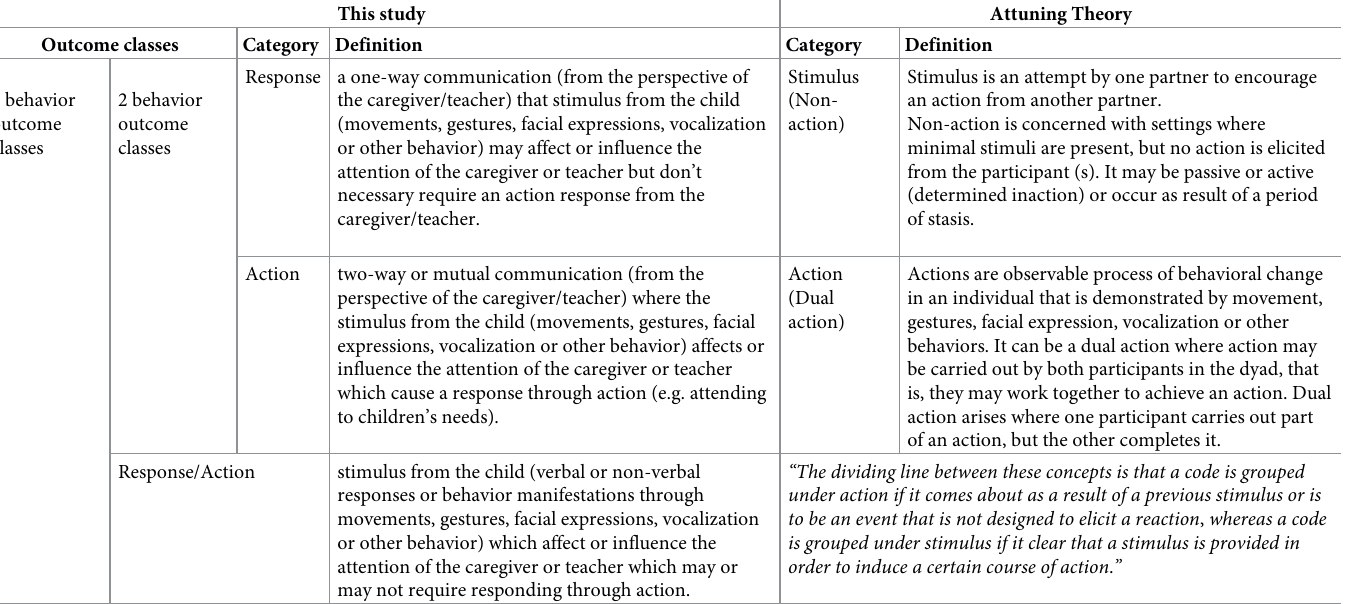
Table 2. Feature (category) description of the 3 and 2 behavior outcome classes in comparison with the Attuning